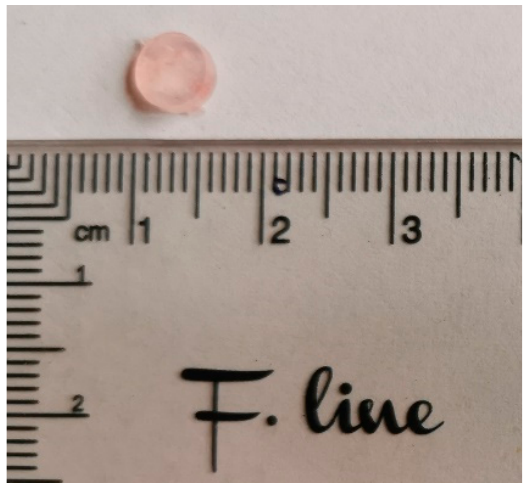
Figure 1. Test samples for